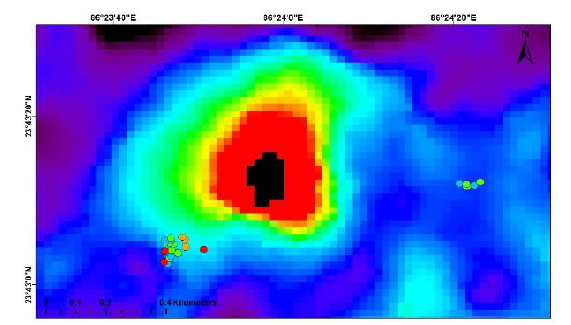
Figure 3. The fringe obtained from D-InSAR overlaid by PS- InSAR